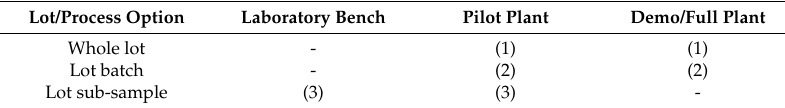
Table 15. Bulk sample/trial mining material processing